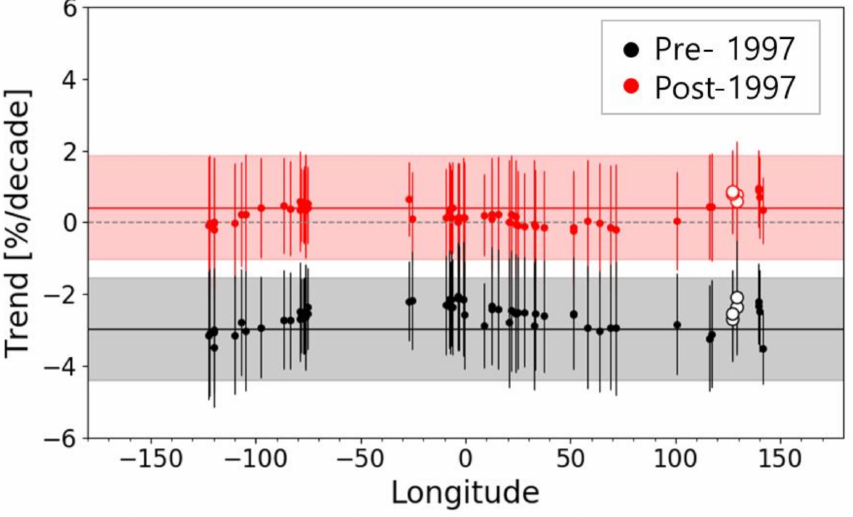
Figure 2. Total column ozone trends at the SBUV overpass stations from the yearly time-series in latitudes between 35–40 ◦ N. The black and red-colored features are related trends for the pre-1997 and post-1997 datasets, respectively. Each point and error bar indicate the trends and 2-sigma uncertainty, respectively, for each SBUV overpass station; unfilled (white) points correspond to stations in the Korean Peninsula. Horizontal solid lines and the shaded range indicate the trend and 2-sigma error for the averaged total column ozone over 35–40 ◦